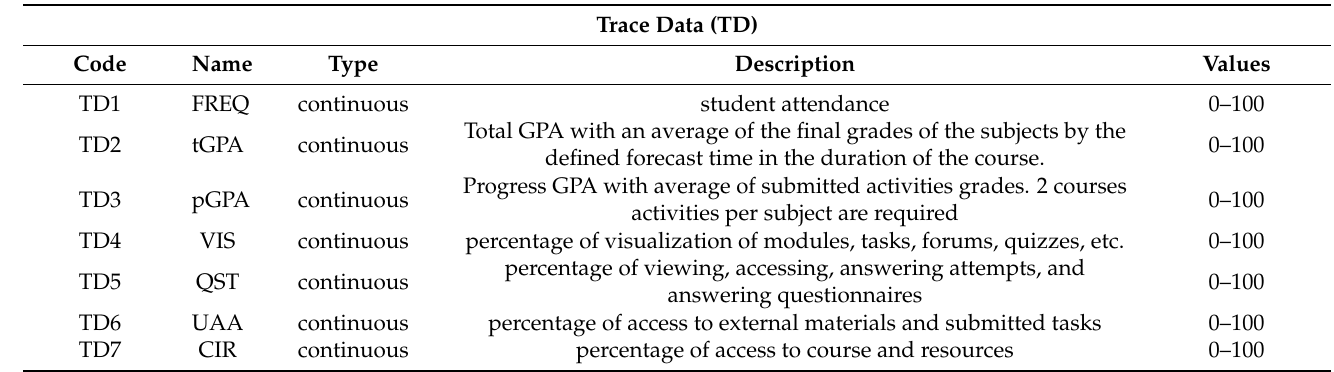
Table 4. Traced Data Attributes, collected from Moodle data. They are aggregated according to their description and normalized to the 0–100